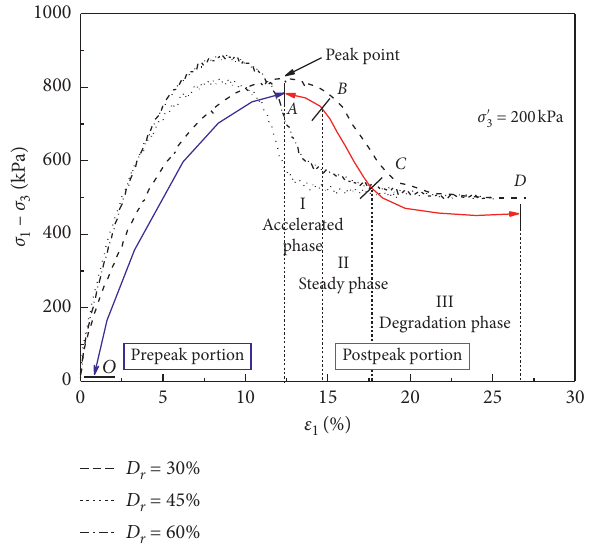
Figure 4: Stress-strain curves of dry calcareous sand with different relative densities.